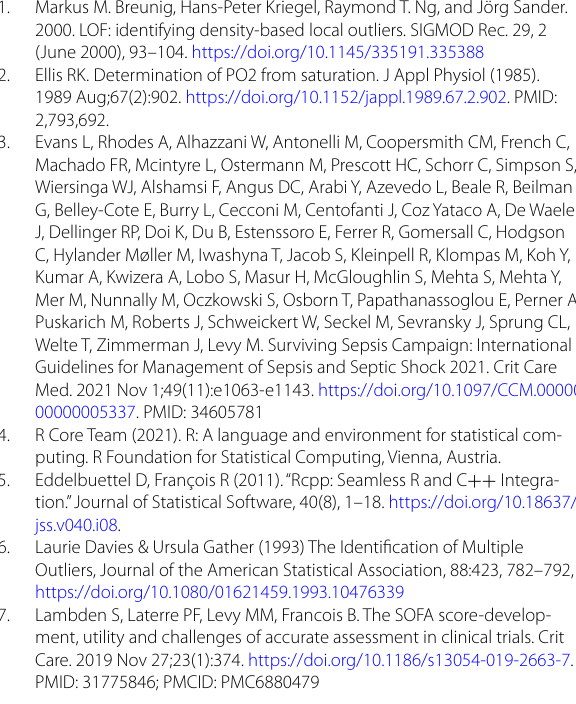
ual chart review, and the SOFA score calculated by the algorithm has predictive performance similar to what has previously been reported from manually calculated admission SOFA